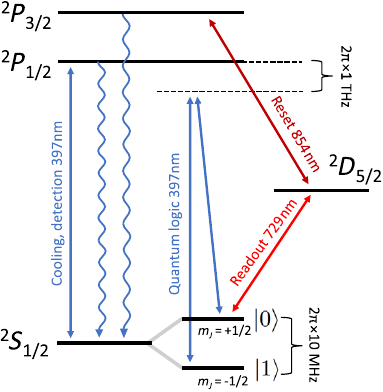
FIG. 11. Relevant atomic levels of a 40 Ca þ ion encoding the spin qubit employed in the work.